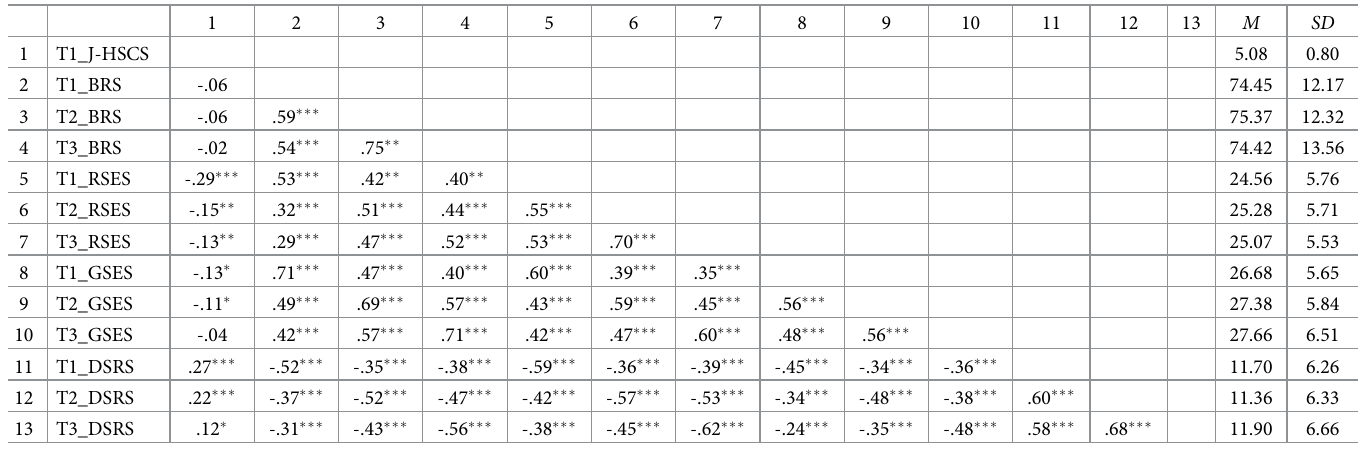
Table 2. Summary of intercorrelations, means, and standard deviations for main variables.